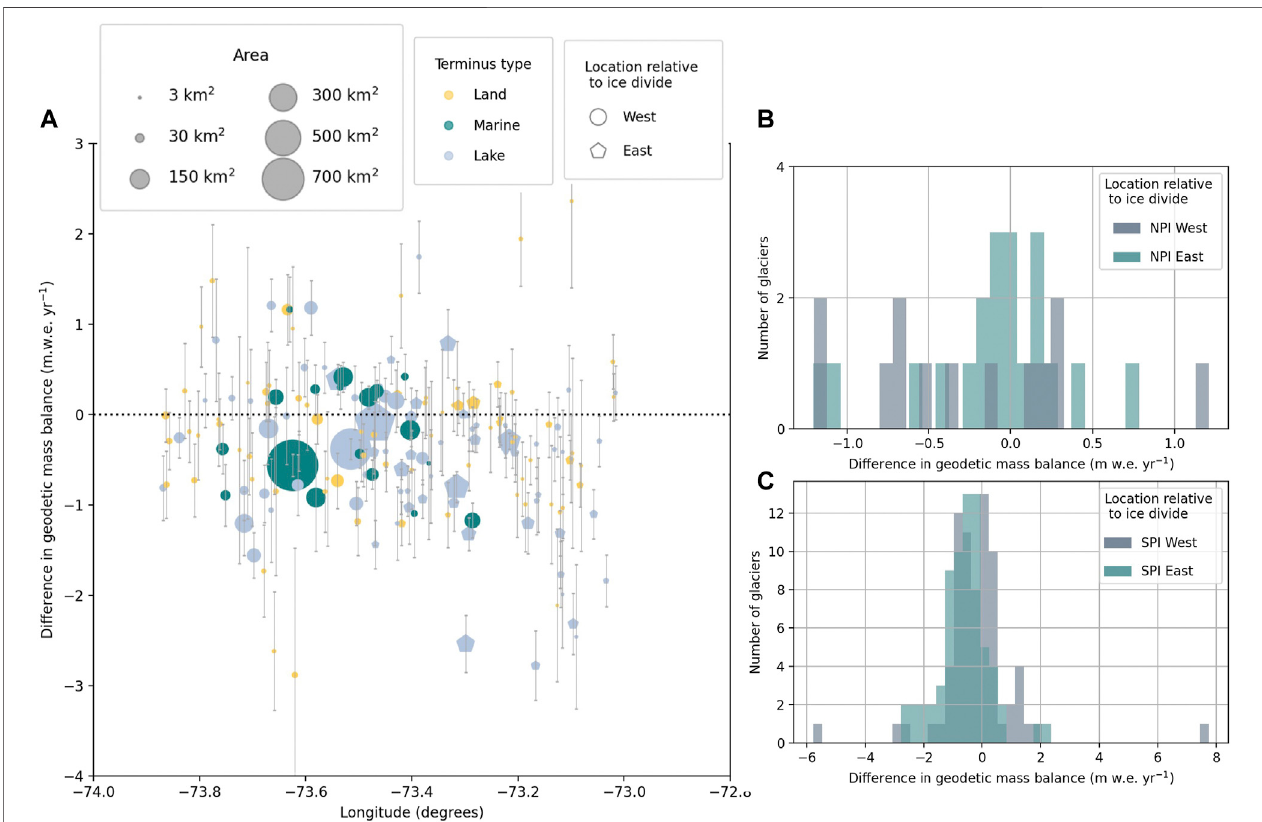
FIGURE 8 | (A) Historical geodetic mass balance subtracted from the modern geodetic mass balance plotted with longitude, which is clipped to show the distribution around zero. Dotted line indicates where no change in geodetic mass balance occurs. (B) displays the full range distribution of geodetic mass balance change for NPI glaciers west and east of the ice divide. (C) is the same as (B) , but for the SPI glaciers.